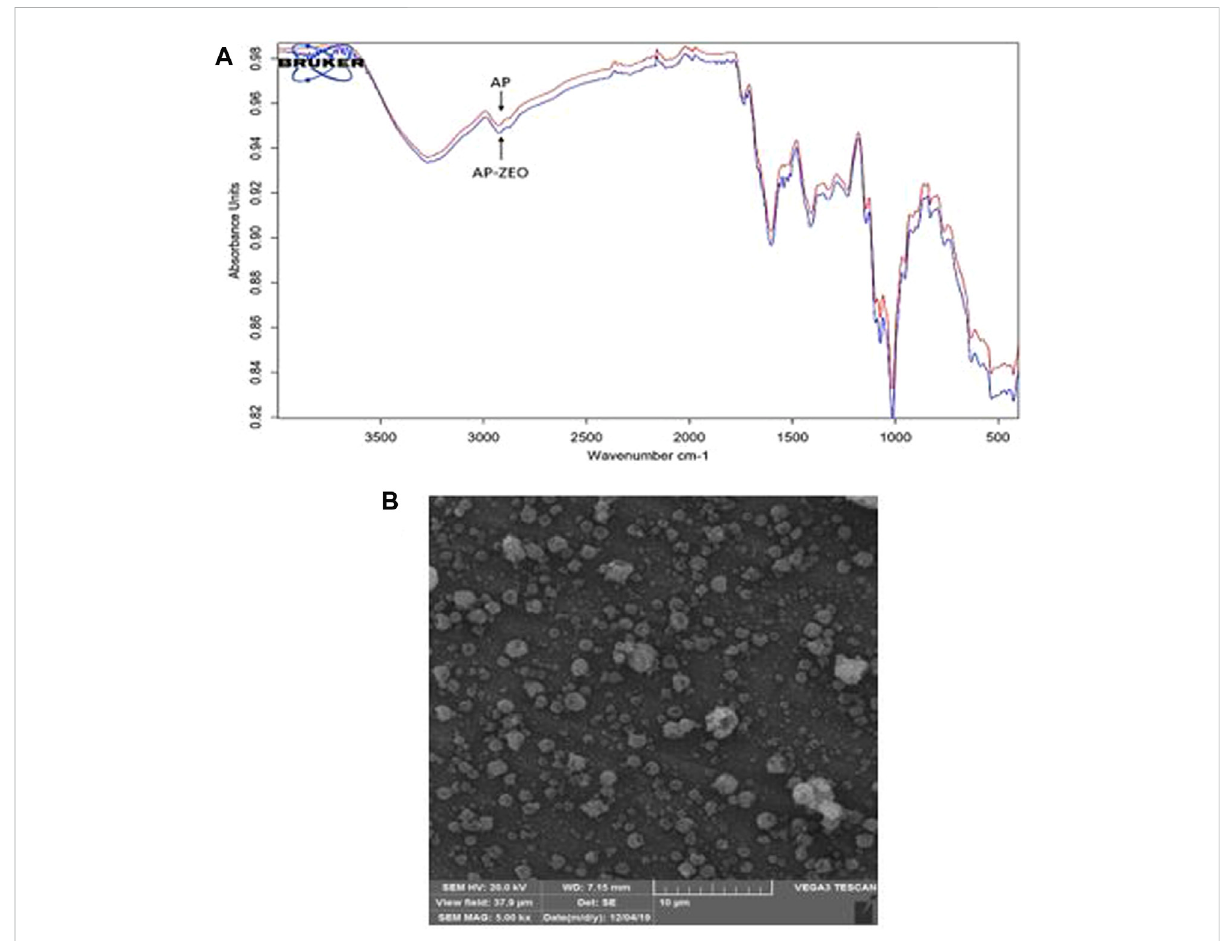
FIGURE 1 (A) FTIR spectra of pectin-polysorbate (AP) AP and AP-ZEONE. High similarity between spectra suggests a non-covalent interaction between AP, polysorbate, and ZEO (B) Scanning Electron Microscopy (SEM) image of AP-ZEONE nanoparticles formed on the aluminum sheet by